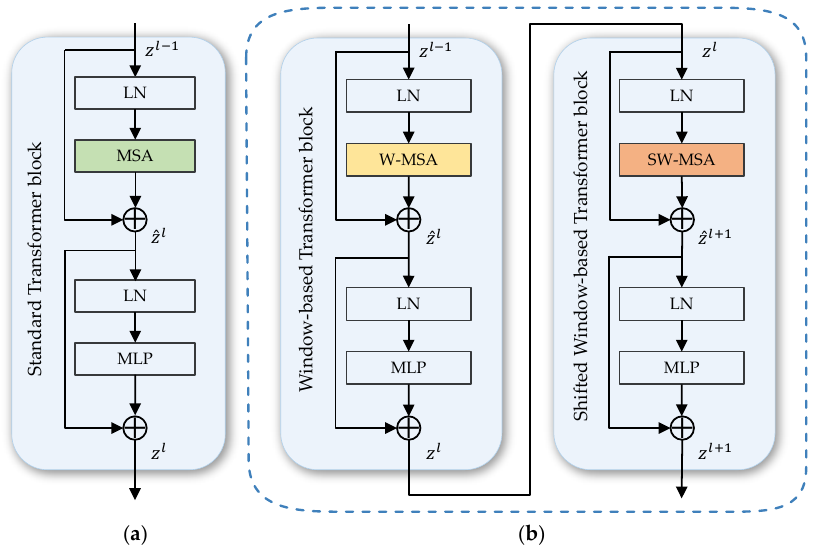
Figure 3. ( a ) The structure of a standard Transformer block [35]. ( b ) Two consecutive Swin Trans- former blocks [41], which are called Window-based Transformer block and Shifted Window-based Transformer block,